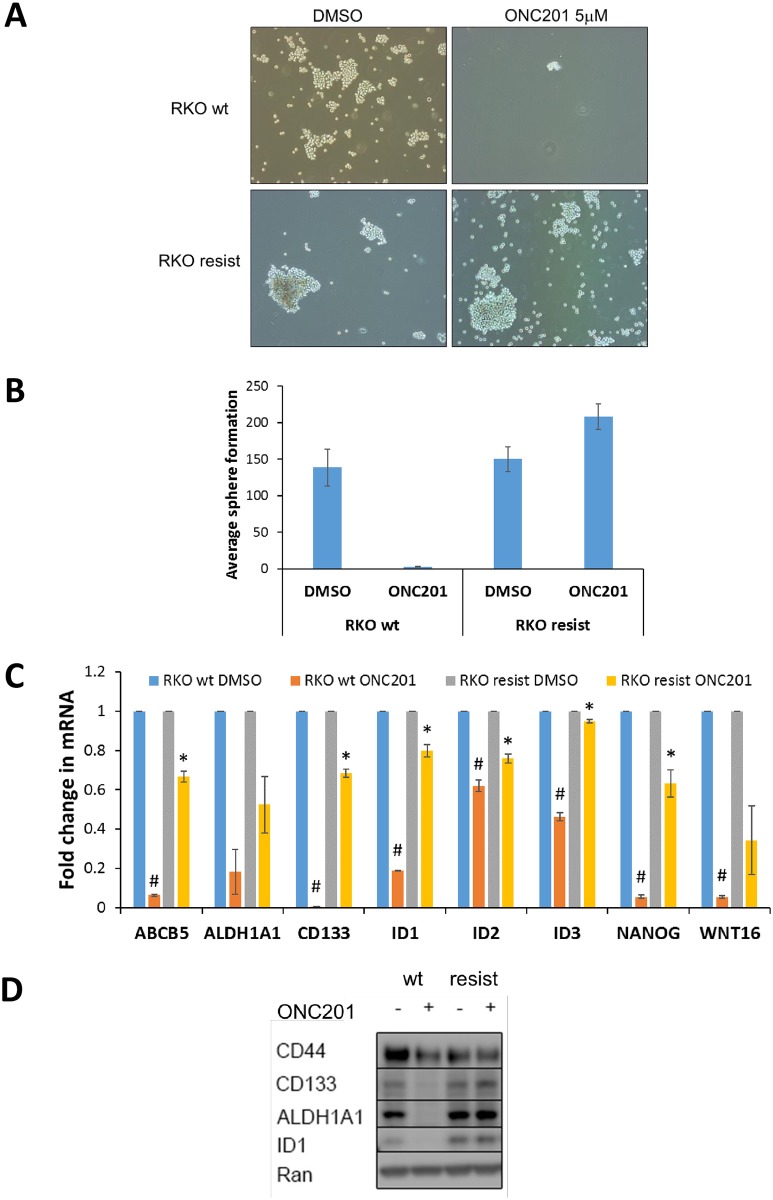
Inhibition of CSCs does not occur in tumor cells with acquired resistance to ONC201.(A) Effect of DMSO/ONC201 (5 μM, 72 h, n = 3) on tumor sphere formation of RKO wild-type (wt) and ONC201-resistant (resist) cells. Representative image (10X magnification) of spheres (> 60 μm) (B) Quantification of spheres in (A). (C) qRT-PCR for indicated stem cell-related genes in DMSO/ONC201-treated (5 μM, 48 h, n = 3) RKO wild-type (wt) and ONC201-resistant (resist) cells. # indicates p < 0.003 relative to wt DMSO. * indicates p < 0.05 relative to wt ONC201. (D) Western blot for indicated stem cell-related proteins in DMSO/ONC201-treated (5 μM, 72 h) RKO wild-type (wt) and ONC201-resistant (resist) cells.